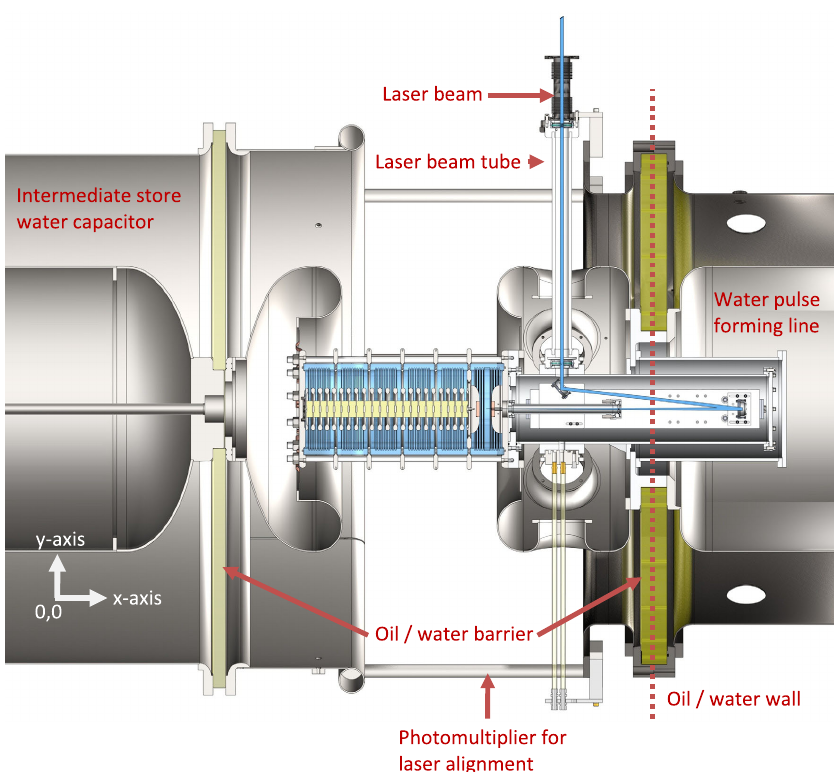
FIG. 3. (Color) Cross section of the intermediate-store water capacitor, the laser-triggered gas switch, the final optics assembly, and first water insulated pulse-forming stage. The gas switch is submerged in mineral oil. The intermediate store is charged negatively in (cid:1) 1 : 4 - (cid:1) s . The laser beam is transported via a Teflon tube and focused by the 50-cm final focusing lens to the center of the trigger